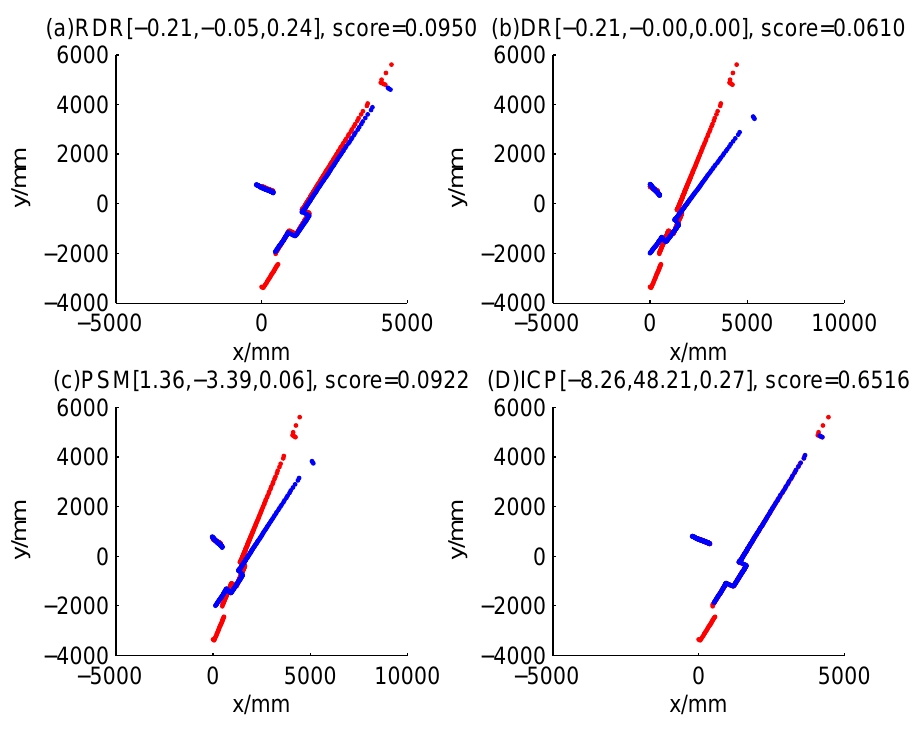
Figure 23. Robust dead reckoning result for Case 4a (time Step